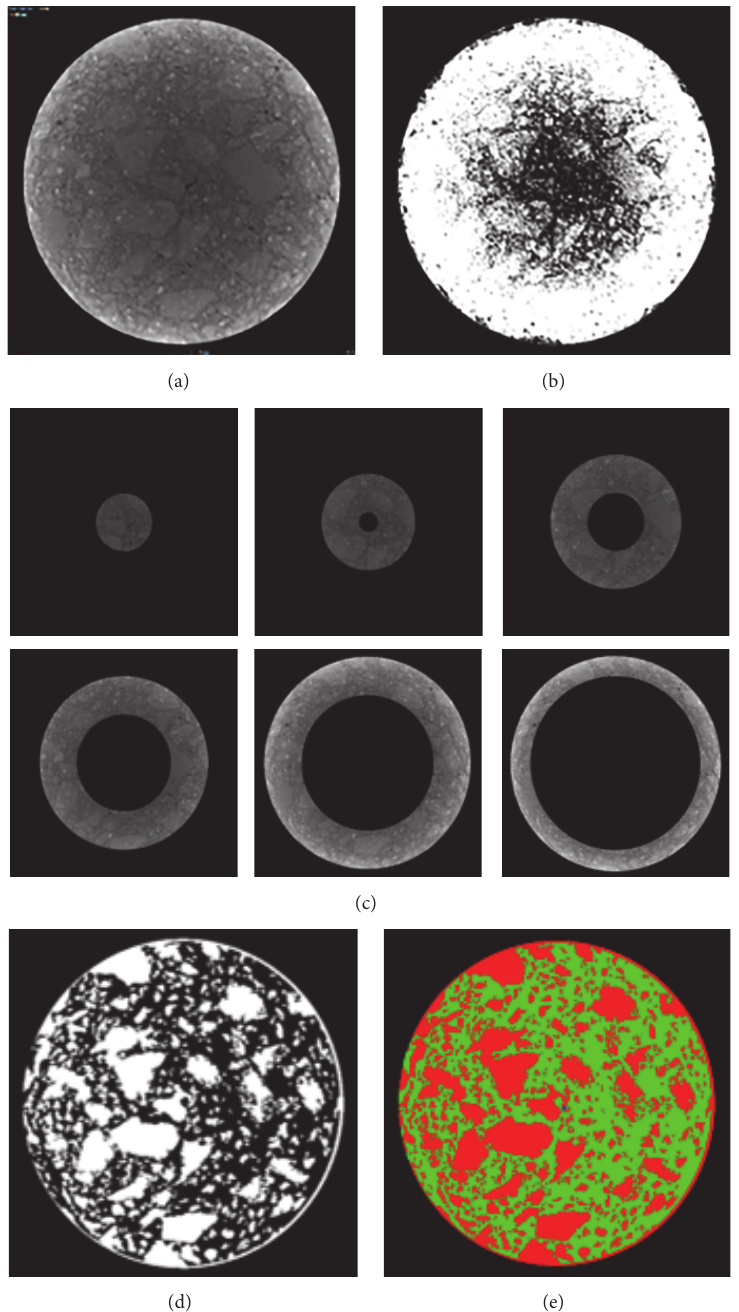
Figure 1: Image segmentation of asphalt mixture CT slices, (a) the original CT image, (b) the segmented image using OTSU method, (c) the subimages decomposed by the improved OTSU method, (d) the segmented image using improved OTSU method, and (e) phase-segmented